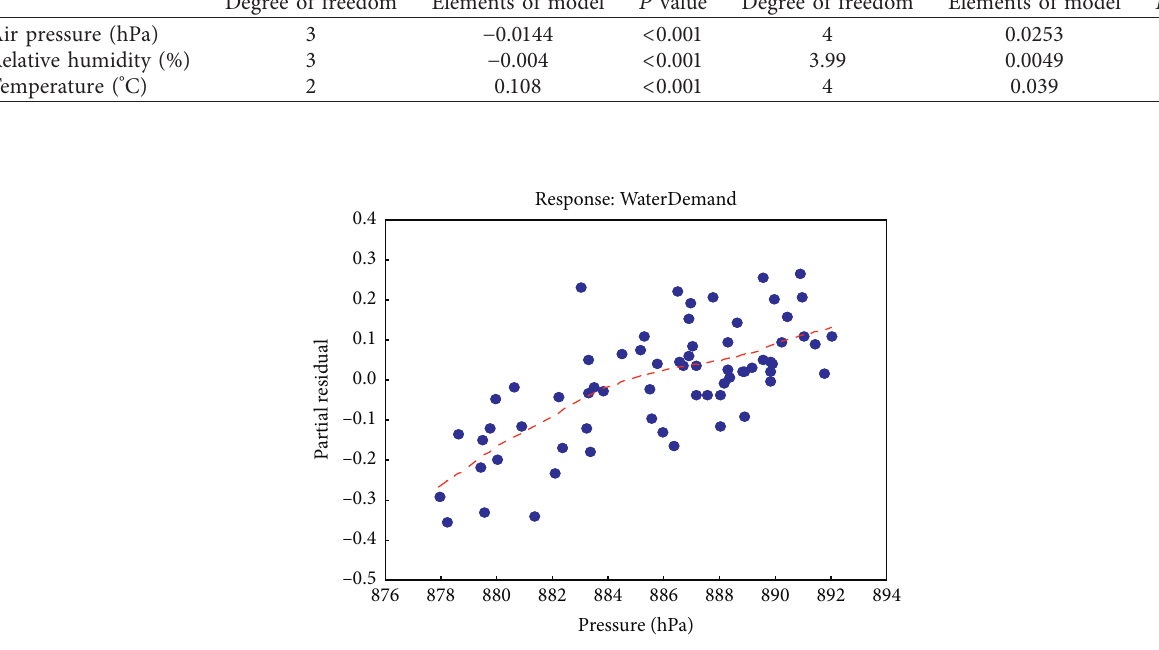
Figure 1: Periodogram of monthly water consumption time series in Khorramabad (2012–2018). Table 2: The results of individual and composite GAM model on meteorological variables versus Khorramabad’s water consumption. Variable